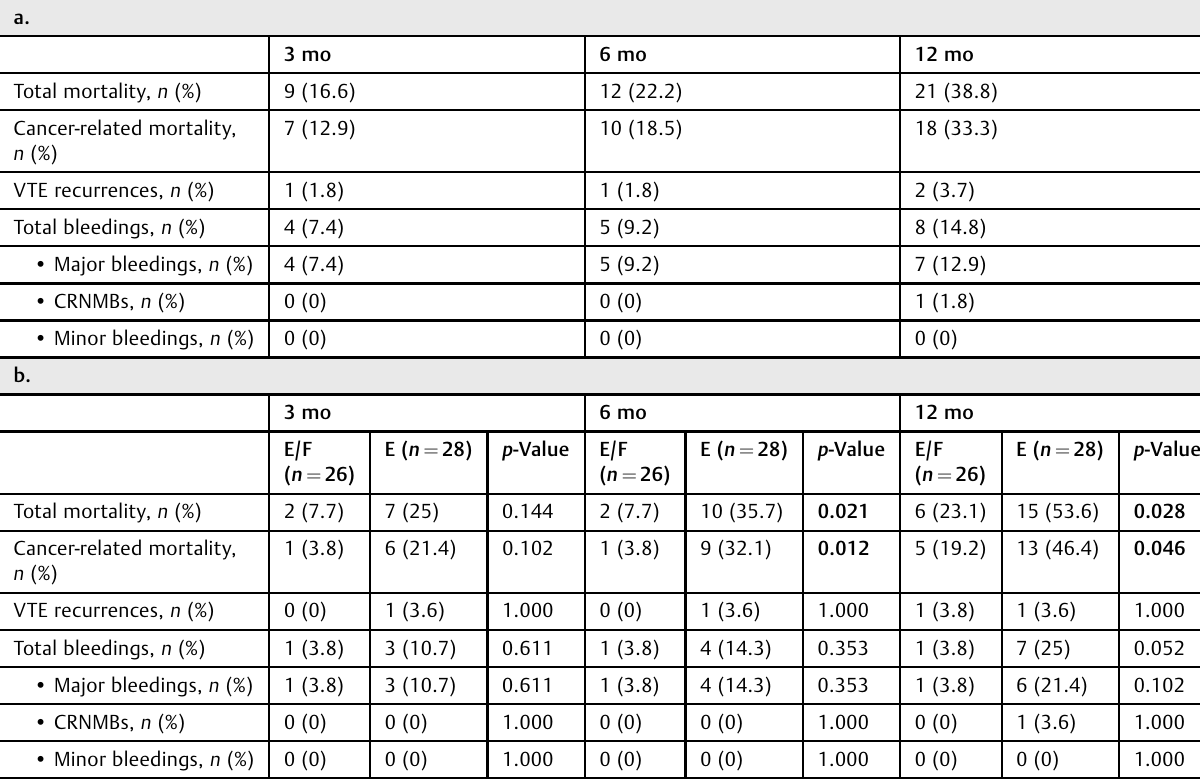
Table 2 Cumulative outcomes at 3-, 6- and 12-month follow-up: all patients ( ► Table 2a ), and comparison between patients treated with enoxaparin/fondaparinux and those treated with edoxaban in the post-acute phase of cancer-associated